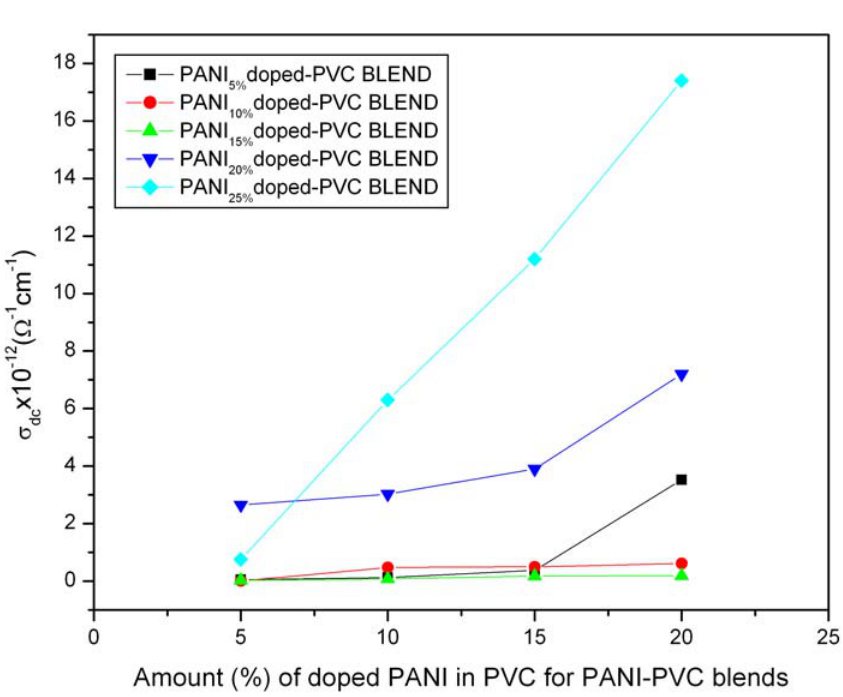
Fig. 1 Variation of dc conductivity for different ratios of doped PANI compared to a fixed ratio of PVC used in the preparation of PANI-PVC